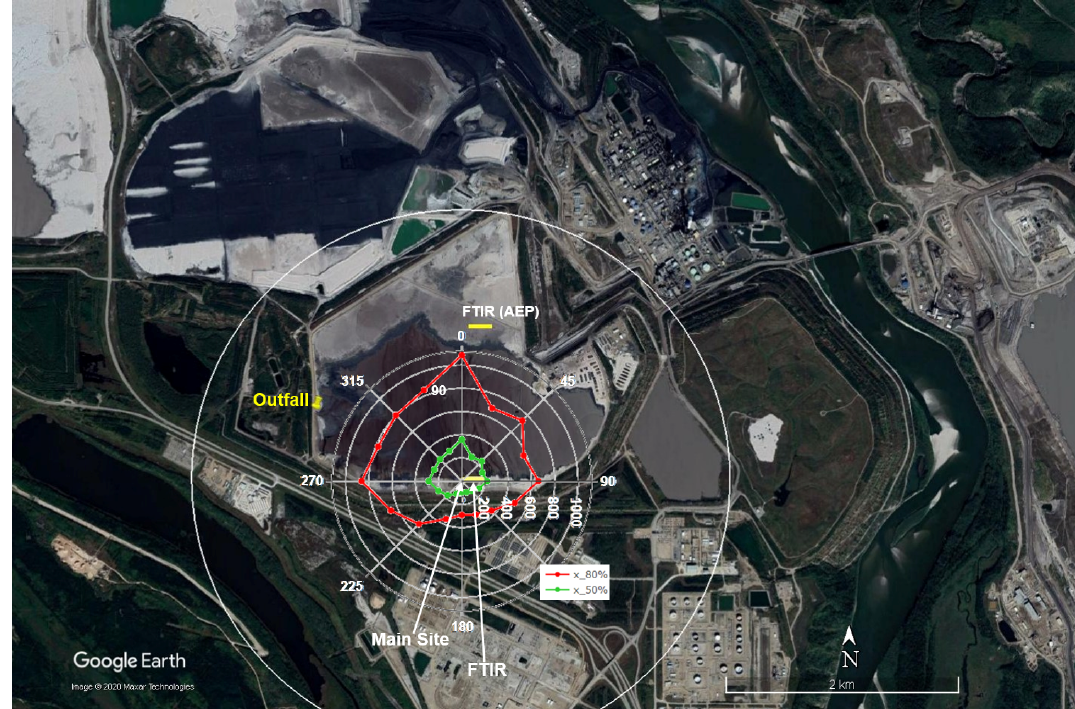
Figure 1. Map of the site: open-path FTIR on the south shore marked in red, open-path FTIR of Alberta Environment and Parks (AEP) on the north shore marked in yellow, and the outfall on the west side. The colored rose plot shows 50% and 80% contribution distances for eddy covariance fluxes at 18m using the Flux Footprint Prediction (FFP) model (Kljun et al., 2015). The unit of contribution distances is in meters. The white circle labels the 2.3km distance from the main site, equivalent to 100 times the height of the highest point of the top FTIR path. This figure is adapted from You et al. (2020), Fig.